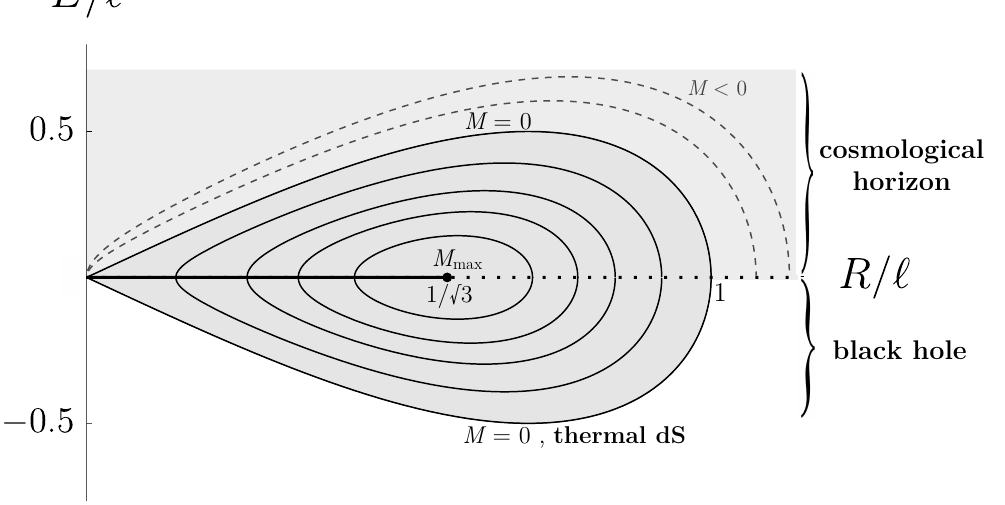
Figure 11. The space of boundary data R and E . The gray region corresponds to regular solutions (that avoid naked singularities). The contours indicate constant-mass curves, which are also constant entropy curves in the upper and lower half-planes, since a given M specifies r b or r c √ uniquely. The mass contours shrink to the Nariai point with R = ‘/ 3 and E = 0 , corresponding √ to the maximum mass, M = ‘/ 3 3 . The dashed curves indicate negative mass parameter, which do not have counterparts in the black hole section. The solid segment on the horizontal axis from the origin to the Nariai point is the case where the system boundary and the black hole horizon coincide. On the remaining (dotted) part of the axis, the system boundary lies on the cosmological